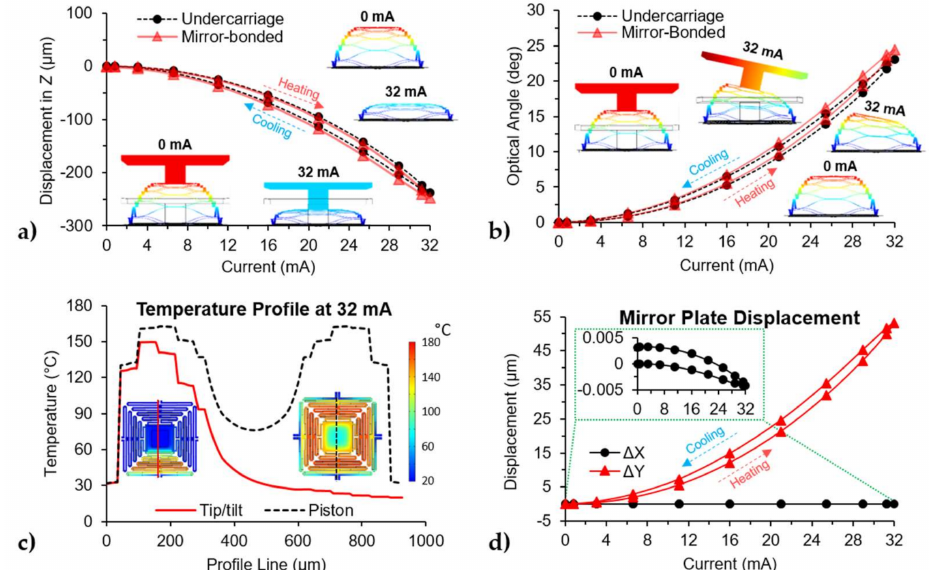
Figure 5. Time-based simulation results for the undercarriage and mirror-bonded device with a sine wave as the input: ( a ) Plots for piston displacement against input current with inset of the simulated devices at different times, where the input is applied to all four actuators at the same time, ( b ) plots for the optical angle against input current with insets of the simulated devices at different times, ( c ) plot for the temperature profile in the X-axis of the undercarriage for tip/tilt and piston actuation, insets show schematic of the undercarriage and the location of the profile line, ( d ) lateral displacement of the mirror plate as the device is actuated for tip/tilt